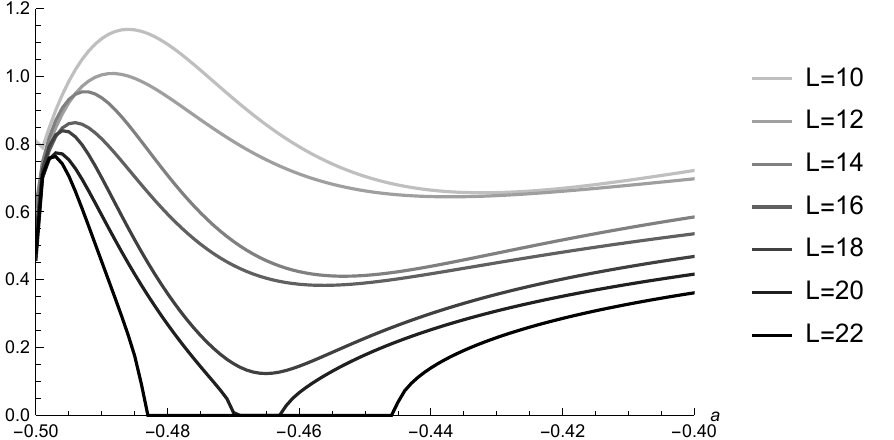
Figure 9 . Plots of Im / Re (2.22) for the “double brane” solution Φ D truncation level L = 10 , 12 , · · · , 22 . The horizontal axis denotes the value of the parameter a . The vertical axis stands at a = − 1 / 2